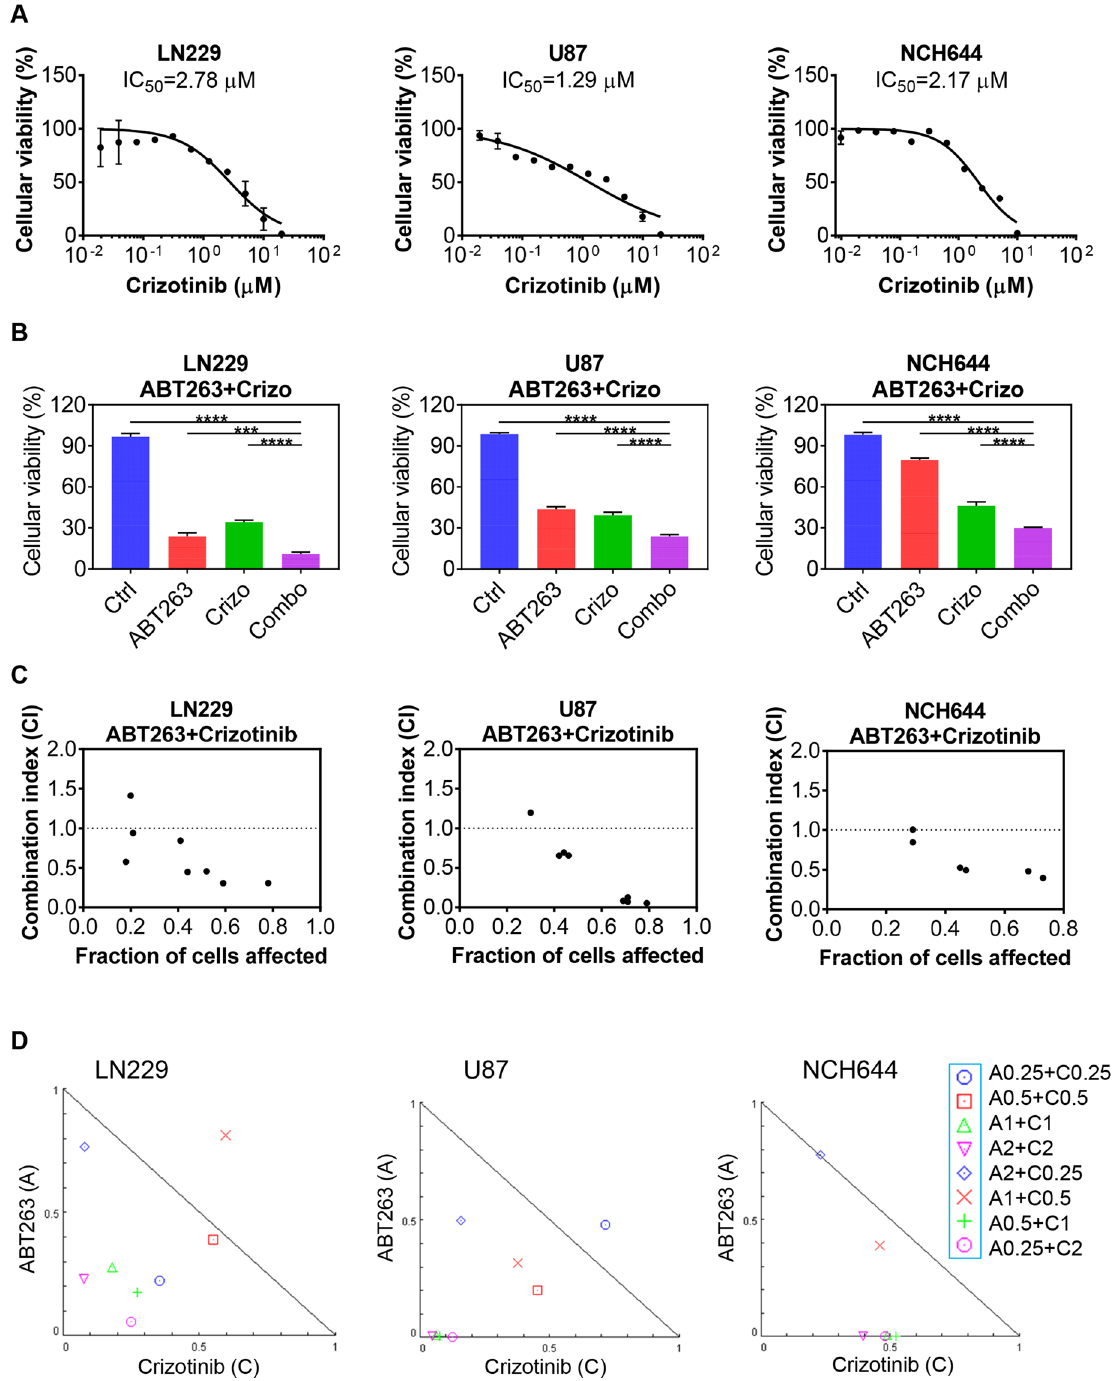
Figure 1. Synergistic interaction of c-MET and Bcl-2/Bcl-xL inhibition in established and stem-like GBM cells. ( A ) LN229, U87 and NCH644 stem-like GBM cells were treated with increasing concentrations with c-MET inhibitor, Crizotinib, and analyzed for cellular viability (3d). Shown are means and SD. Non-linear regression analysis was applied to calculate IC 50 values. n = 3 ( B ) The same cell lines as in A were treated with suboptimal dosages of ABT263, Crizotinib or the combination and analyzed for cellular viability after 72 h. Shown are means and SD. n = 3 ( C , D ) Based on viability assays, CI values were calculated, using the software CompuSyn (ComboSyn, Inc., Paramus, NJ, U.S.A.). CI values below 1 indicate synergistic interactions, whereas values above 1 show antagonism (CI values vs. fraction affected). Isobolograms are further highlighting the synergistic interaction between ABT263 and Crizotinib. The applicable concentrations (in μ M) for the used compounds are shown on the right side of the figure. A: ABT263, C: